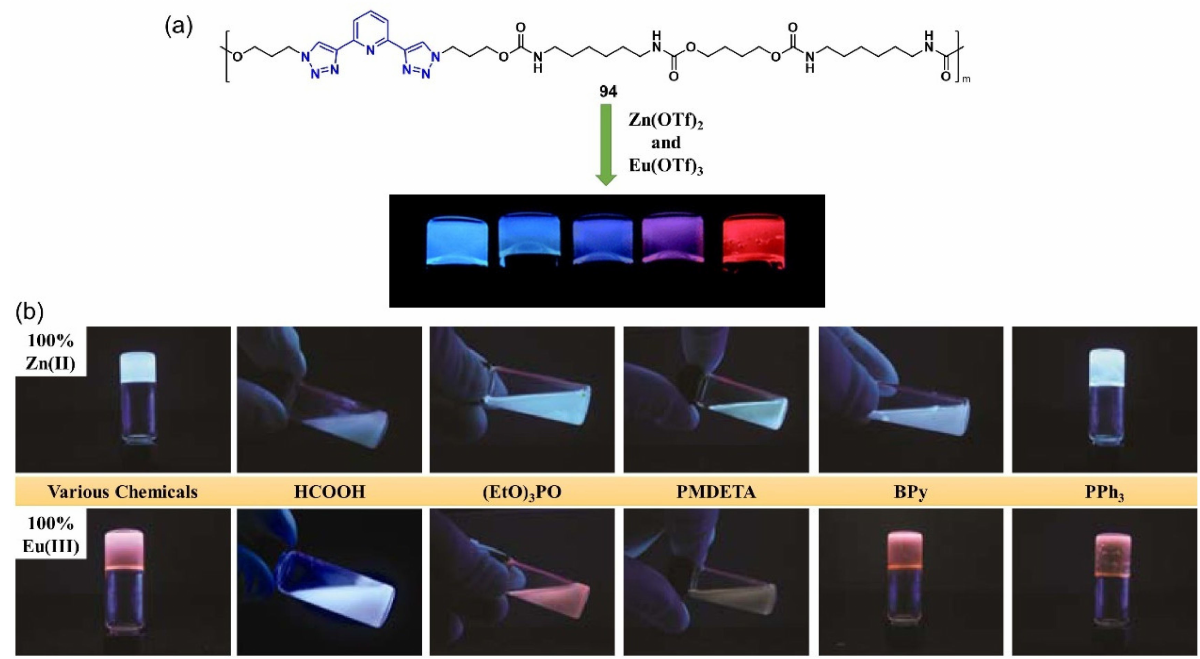
Figure 39. ( a ) Picture of gels (20 mg mL − 1 in chloroform) derived from polymer 54 with varying amounts of Zn(II) and Eu(III) (from left to right, Zn/Eu: 100/0, 75/25, 50/50, 25/75 and 0/100) under 365 nm UV light, demonstrating the effects of different metal combinations on the photoluminescence color. ( b ) Chemo-responsiveness of gels to various chemicals. Reprinted with permission from Ref. [118]. Copyright (2012), Royal Society of